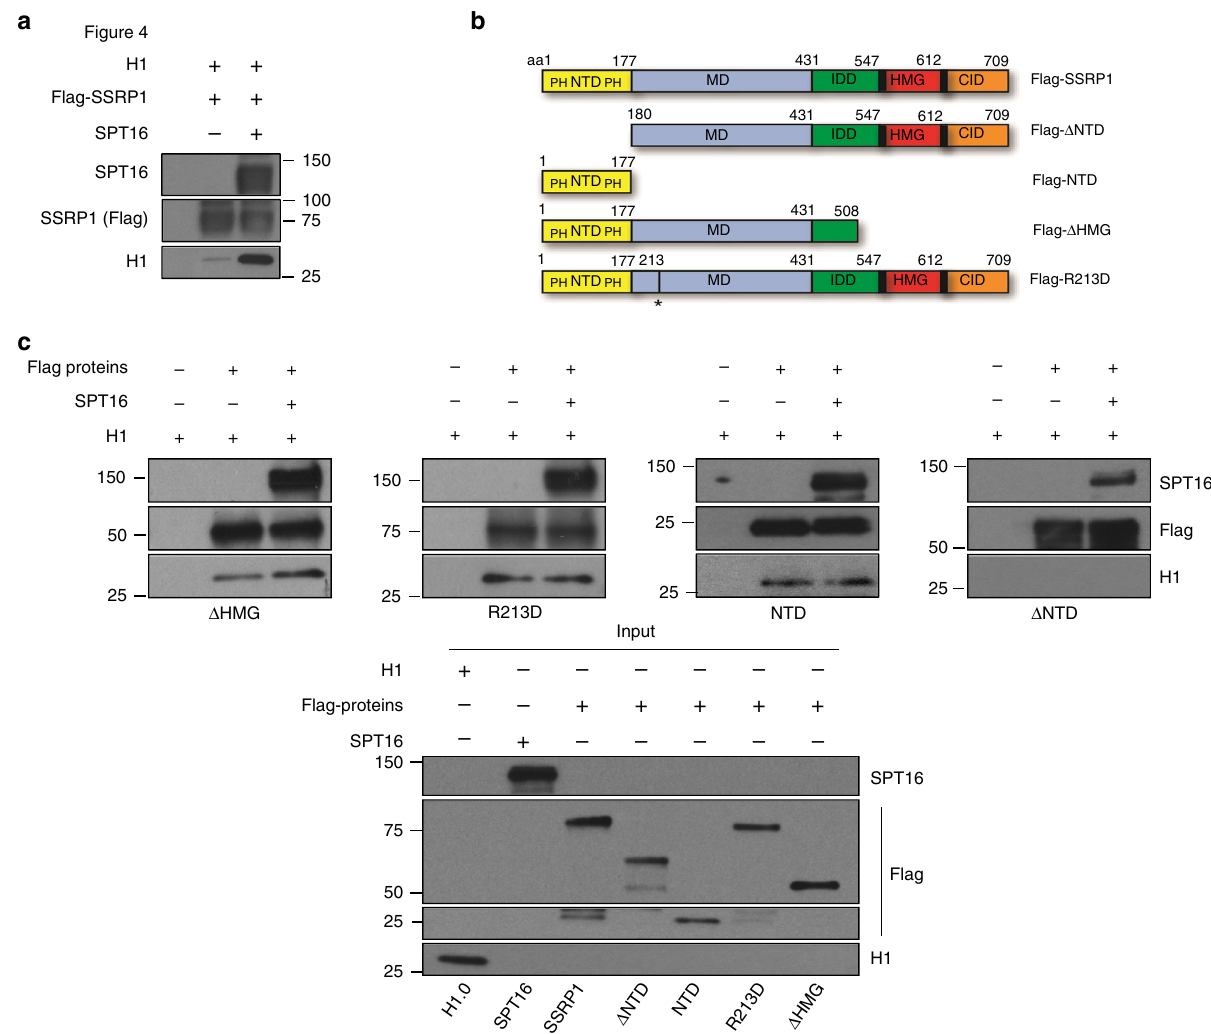
Fig. 4 SSRP1 interaction with histone H1 through its N terminal domain. a WB of Flag pull-down performed with recombinant human SPT16, Flag-SSRP1 and puri fi ed histone H1 using the indicated antibodies. b Schematic representation of Flag-SSRP1 mutated recombinant proteins used. Structural domains of wild-type SSRP1 protein are marked in color: N-terminal domain, NTD (Yellow); intrinsically disordered domain, IDD (green); C-terminal domain, CID (orange); Middle domain, MD (blue); HMG-box (red) and positively charged domains (black). Numbers indicate amino acid residues. PH indicates pleckstrin homology domain. *Indicates mutated residue. c ) WB of in vitro pull-downs using the anti-Flag antibodies bound to agarose beads incubated with the indicated combinations of recombinant wild-type and mutant proteins. The mutated Flag-SSRP1 proteins used for the pull-downs are indicated under each panel. The inputs are shown in the panel below